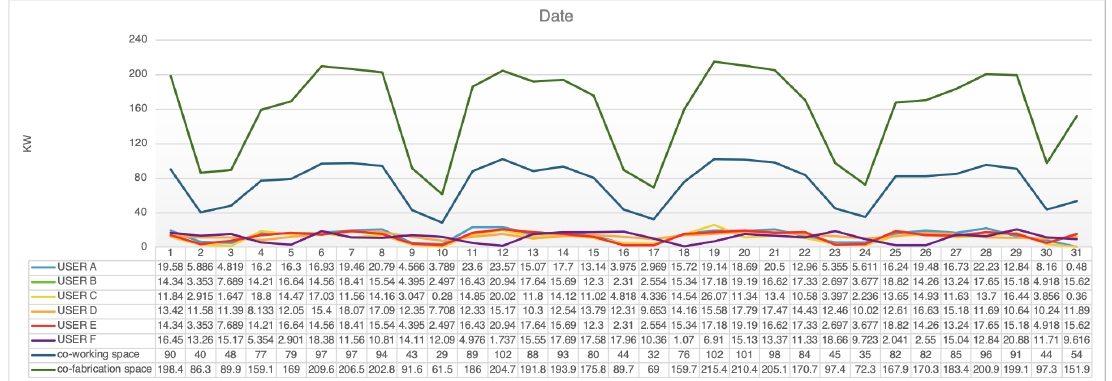
Figure 9. Different space compare